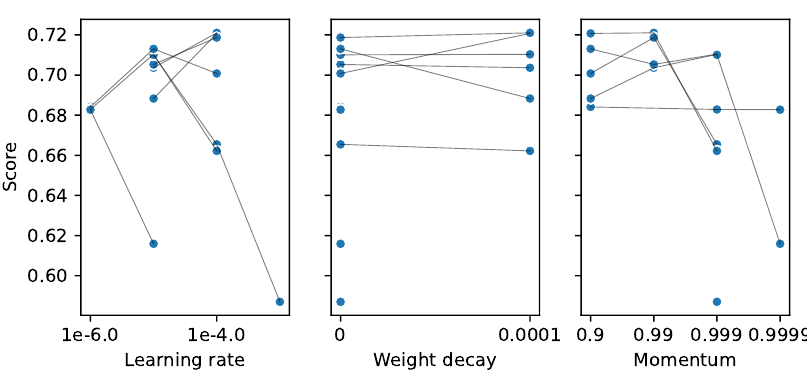
Figure A6. Dependence of the validation instance discrimination score on learning rate, weight decay and momentum for the UVP5/EcoTaxa ( top ) and the ZooScanNet ( bottom ) dataset.